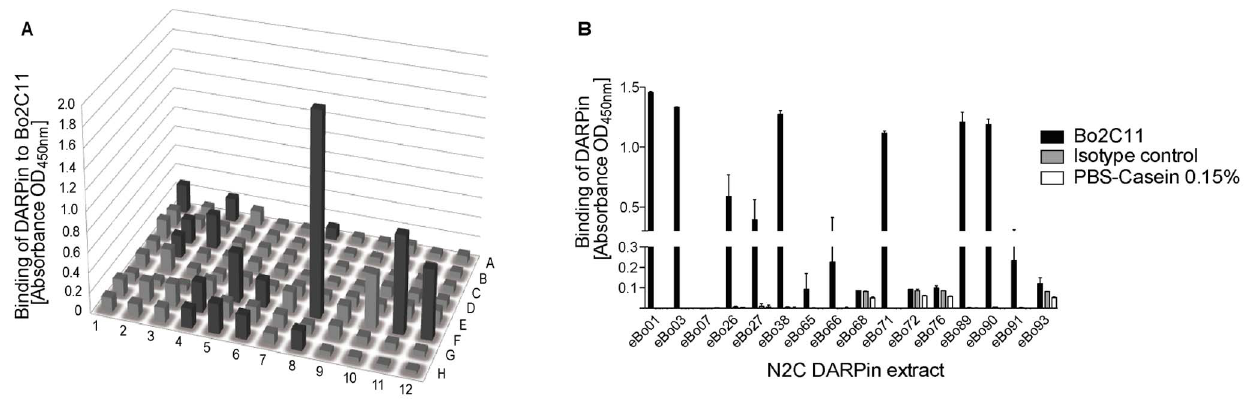
Figure 1. Screening of DARPin clones after third selection round. A) Crude extracts of 96 individual DARPin clones were tested for binding to the target antibody, Bo2C11. Extracts were diluted 1:10 and binding of DARPins was revealed using a murine anti-His 6 antibody and a peroxidase- labeled anti-mouse IgG antibody. Clones 1–12 are shown in row A, clones 13–24 in row B and so on. Clones chosen for retesting are highlighted in dark grey. B) Re-testing of positive clones. The highlighted clones depicted in Fig.1A were again tested on Bo2C11 (black bars), an isotype control antibody (grey bars) and the blocking agent (white bars) diluted 1:10. DARPin binding was revealed with a murine anti-His 6 antibody and a horseradish-peroxidase labeled goat anti-mouse antibody.